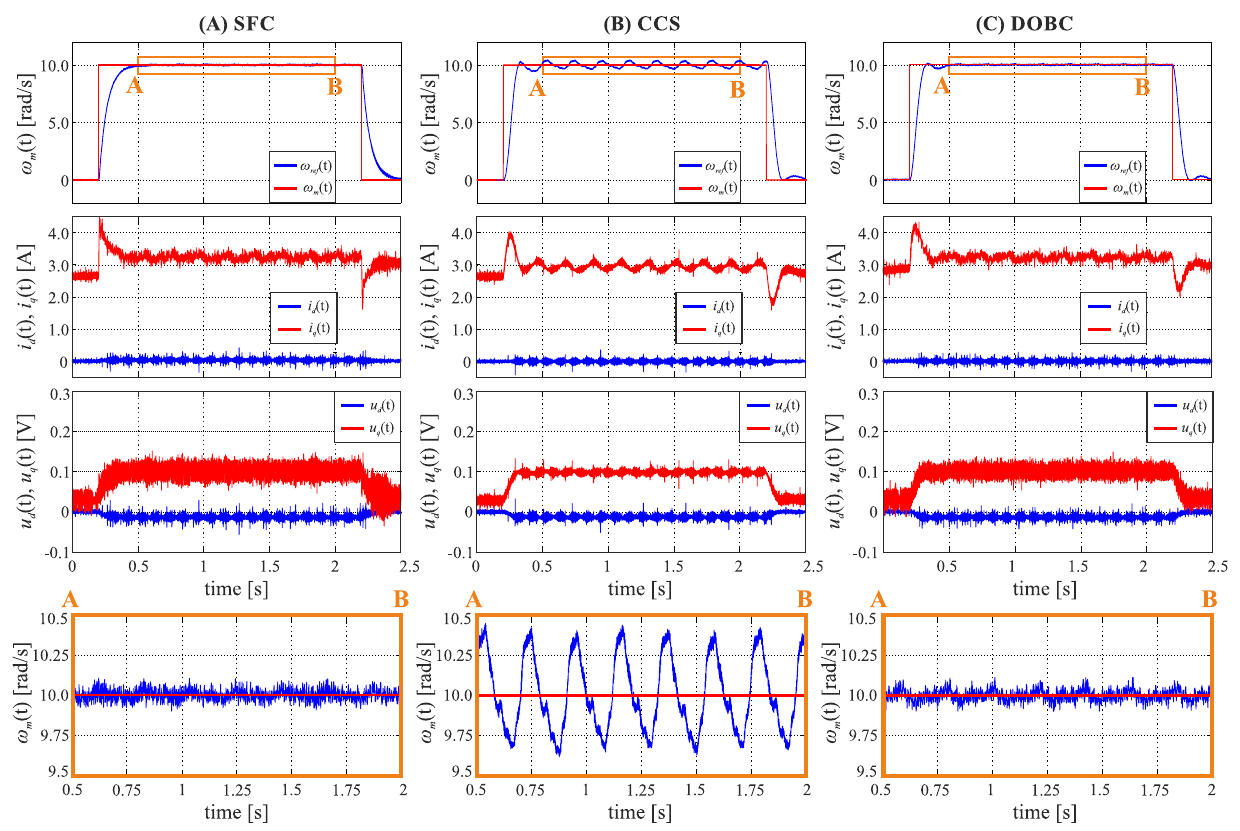
Figure 10. Step response of the investigated control structures for the reference signal of 10 rad/s with a constant load (3 Nm): ( A ) state feedback controller, ( B ) PI based cascade control structure, ( C ) PI based cascade control structure with disturbance observer.